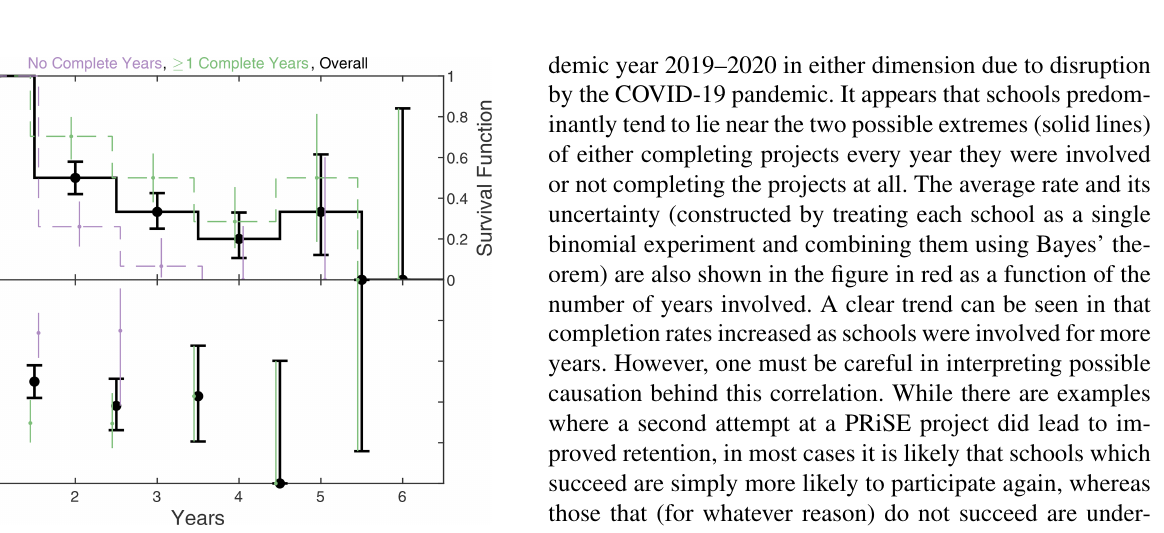
Figure 4. Schools’ survival (top) and hazard (bottom) functions across interventions. Overall results in black; colours subdivide by (a) project and (b) year. Error bars denote standard Clopper and Pearson (1934) intervals.